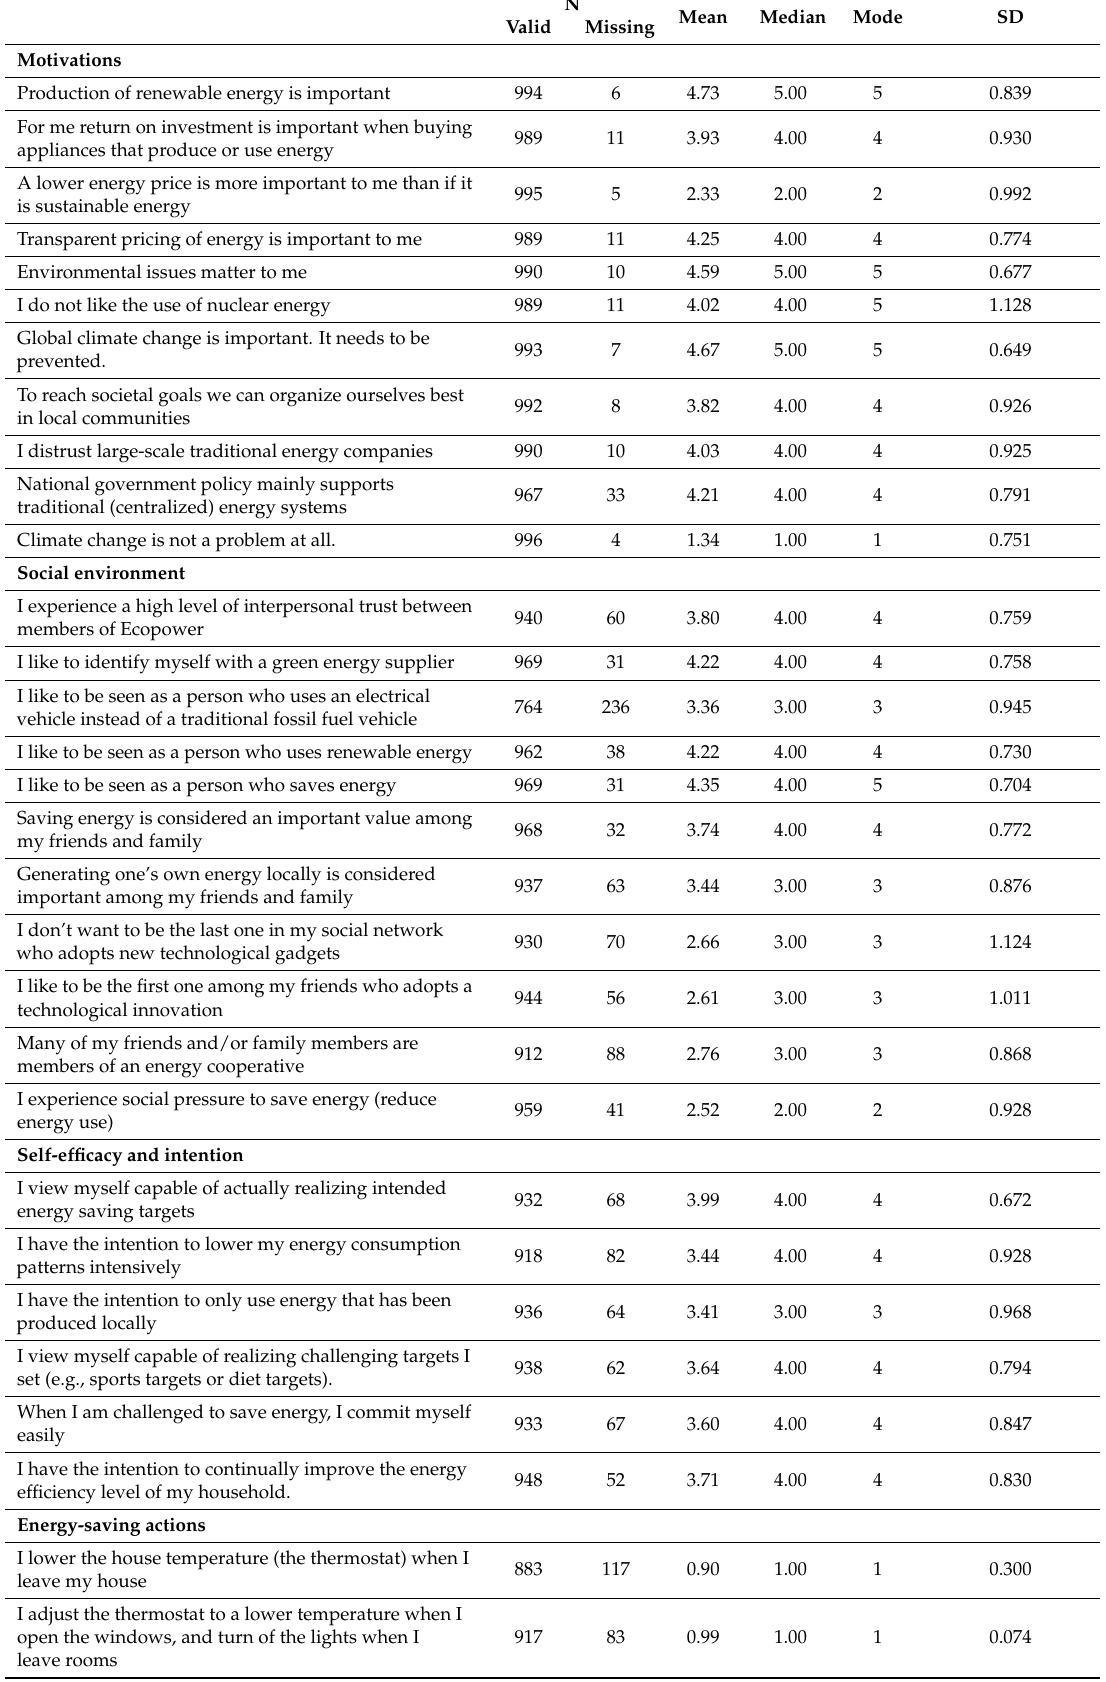
Table A3. Descriptive statistics of